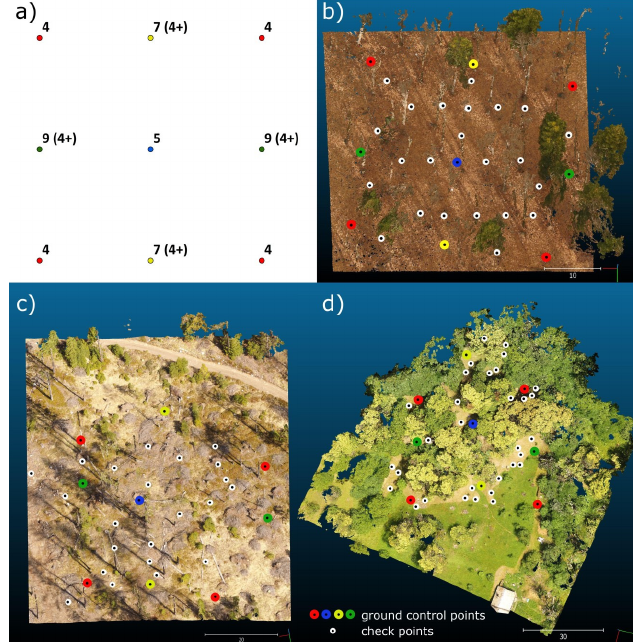
Figure 3. Ground control points (GCPs) and checkpoints. ( a ) The design of the GCP configurations (4: four-GCP “corner”; 4+: four-GCP “cross”; 5: fifth point in the middle; 7: two more points in the slope direction; 9: two more points in the direction of the contour lines). Actual distribution of ground control points and checkpoints on the Kremnica Mountains; ( b ) High Tatras ( c ); and Modr ý Kameˇn ( d )